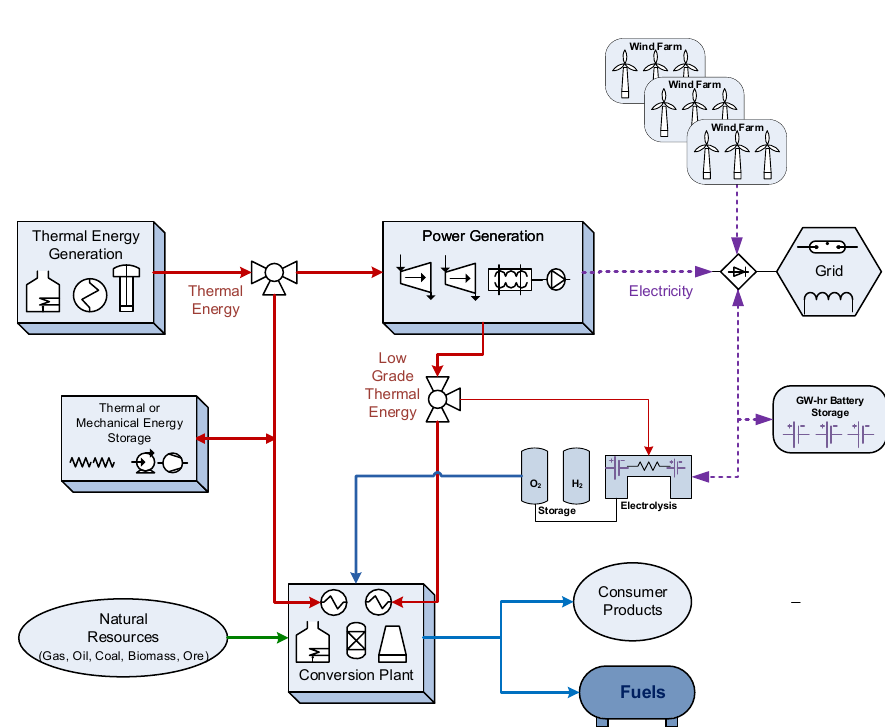
Figure 1. Example integrated energy systems (IES) architecture. Not indicative of any design, but rather just illustrative of how integrated energy systems utilize both heat and electricity.